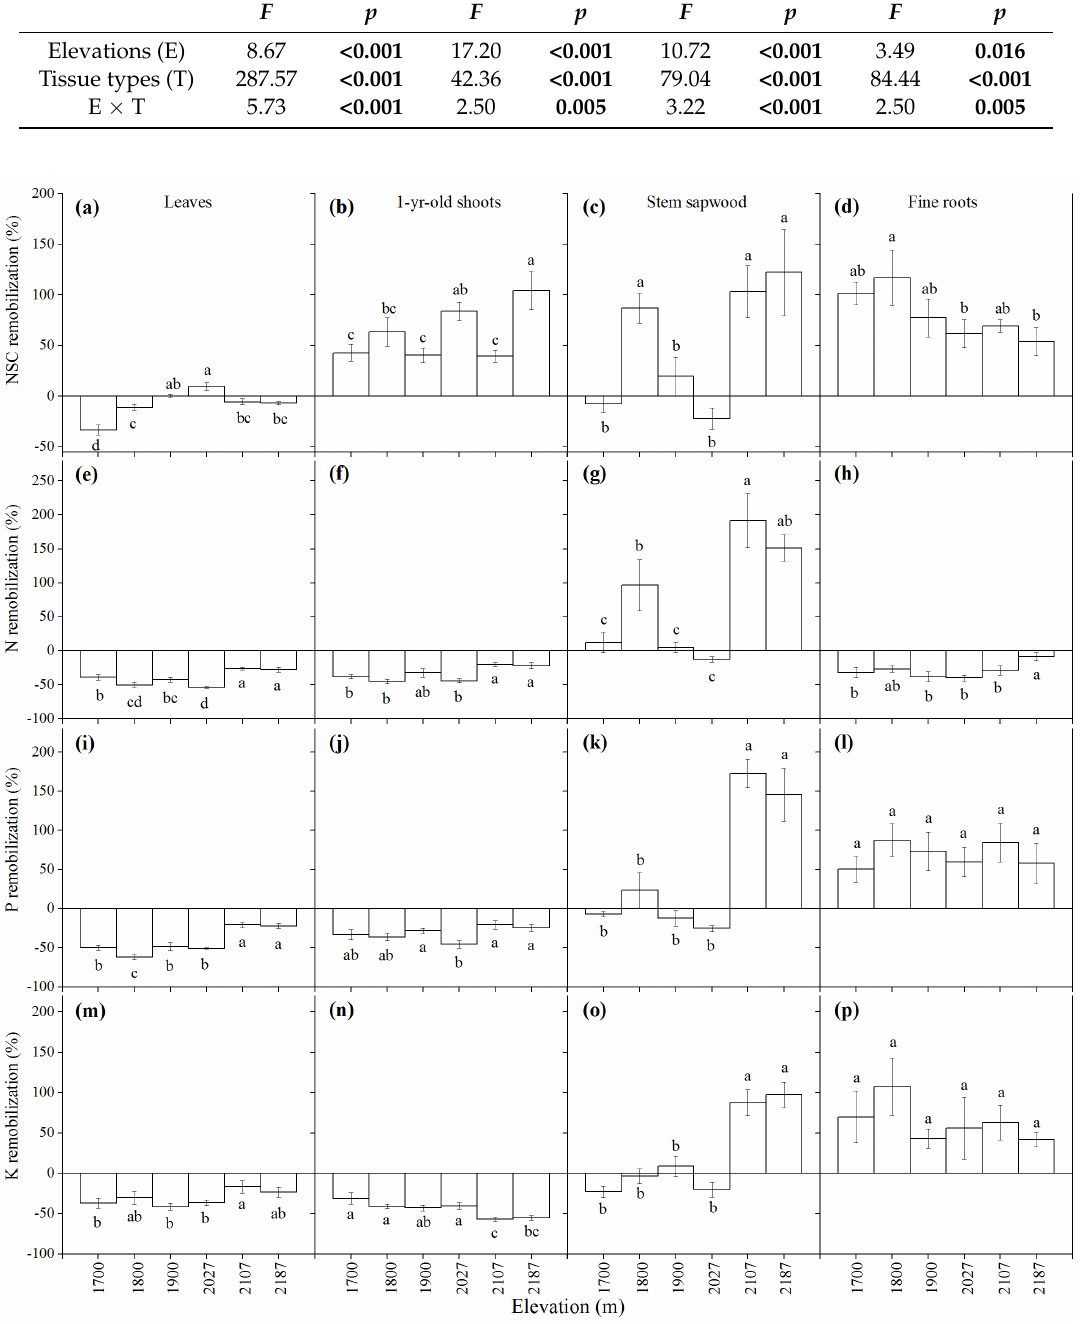
Figure 5. Carbohydrates, N, P and K remobilization efficiency (Mean ± 1SE) (R %) in Betula ermanii trees along the altitudinal gradients in Changbai Mountain ( n = 5 for each elevational site and tissue type). Different letters display significant differences at the 0.05 level among elevations as determined by Duncan’s test (A negative R -value indicates resource translocation, whereas a positive R -value reflects resource accumulation). Table 3. Results of two-way nested ANOVAs with elevation and tissue types as fixed factors. The F and p values are given. R refers to remobilization rate.